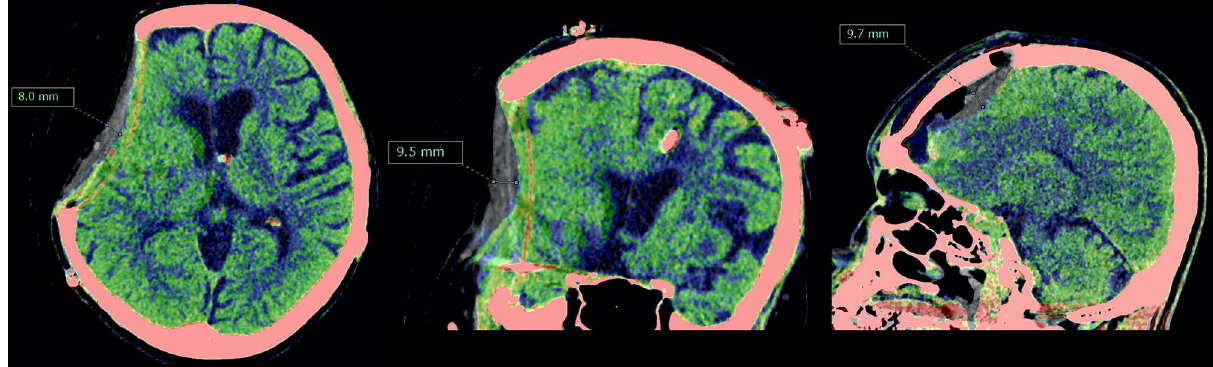
Figure 1. Positional brain shift measurement. Supine (black and white) and upright (mapped with color) images were compared after automatic rigid registration of two datasets based on cranial bones. This enabled three-dimensional assessment of positional brain